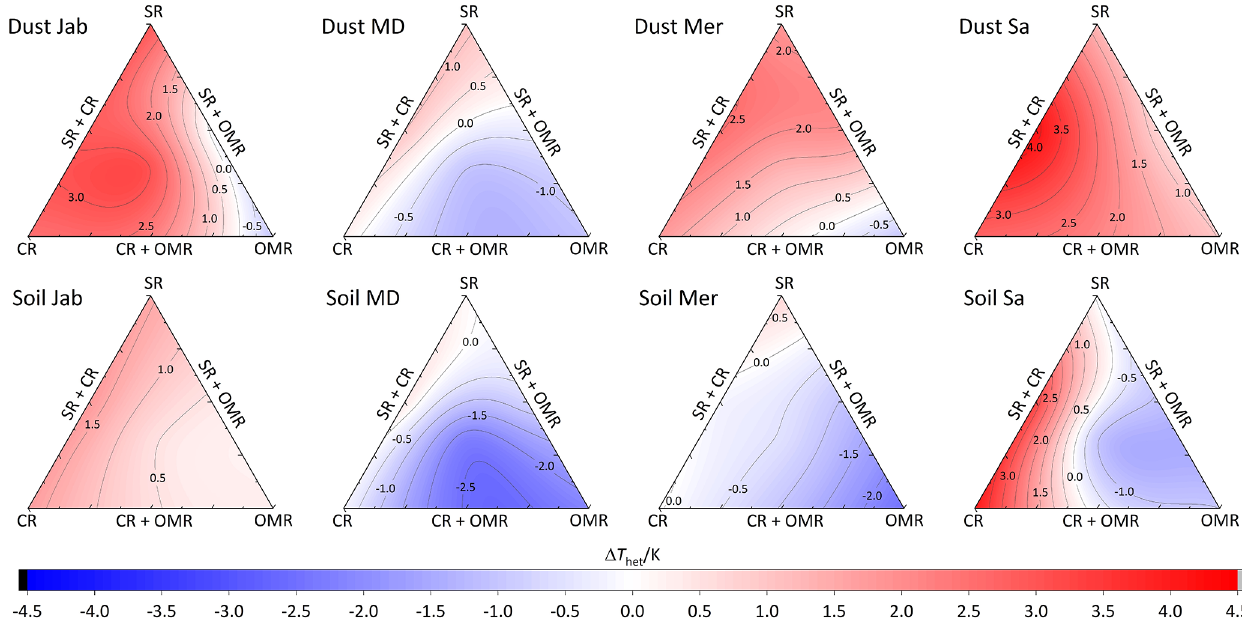
Figure A2. Effects of treatments in terms of (cid:49)T het(treatment-natural) for dust and soil samples at 2wt% concentration. SR: salt removed; CR: carbonate removed; OMR: organic matter removed; SR + CR: salt and carbonate removed; SR + OMR: salt and organic matter removed; SR + CR + OMR: salt-, carbonate-, and organic-removed treatments.